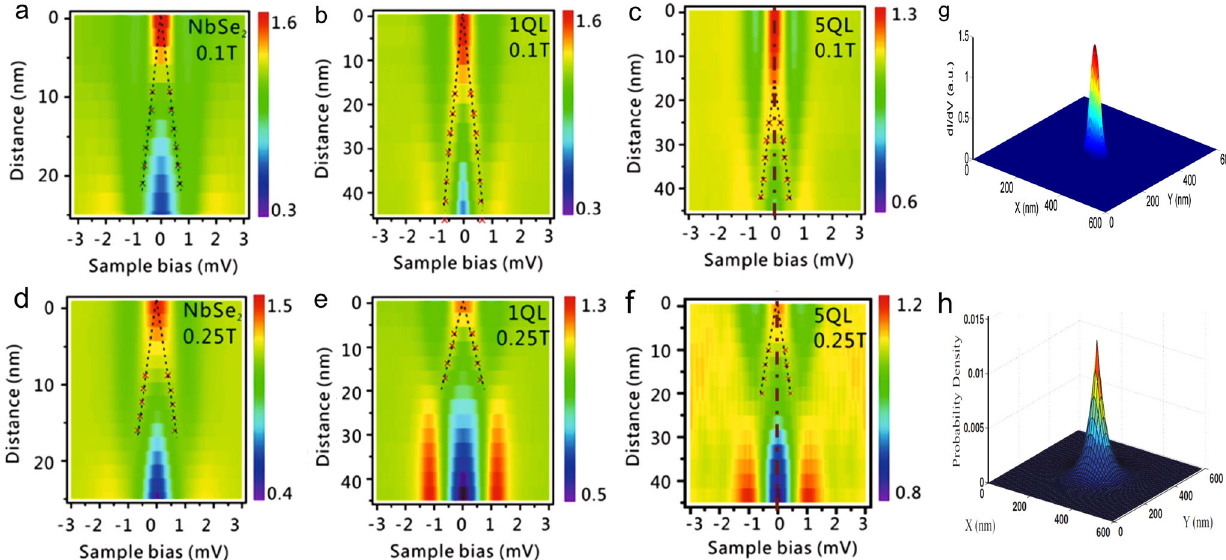
Fig. 7 a – f Comparison of the splitting starting point for different samples and at different magnetic fi elds. The Y-shape splitting pattern can only be observed on 5 QL Bi 2 Te 3 sample at 0.1 T magnetic fi eld. g Spatial distribution of the MZM detected in the vortex core on a 5 QL Bi 2 Te 3 / NbSe 2 sample. h The spatial distribution of MZM in the vortex calculated in ref. 41 (reprinted with permission from ref. 41, copyright 2011 by the American Physical